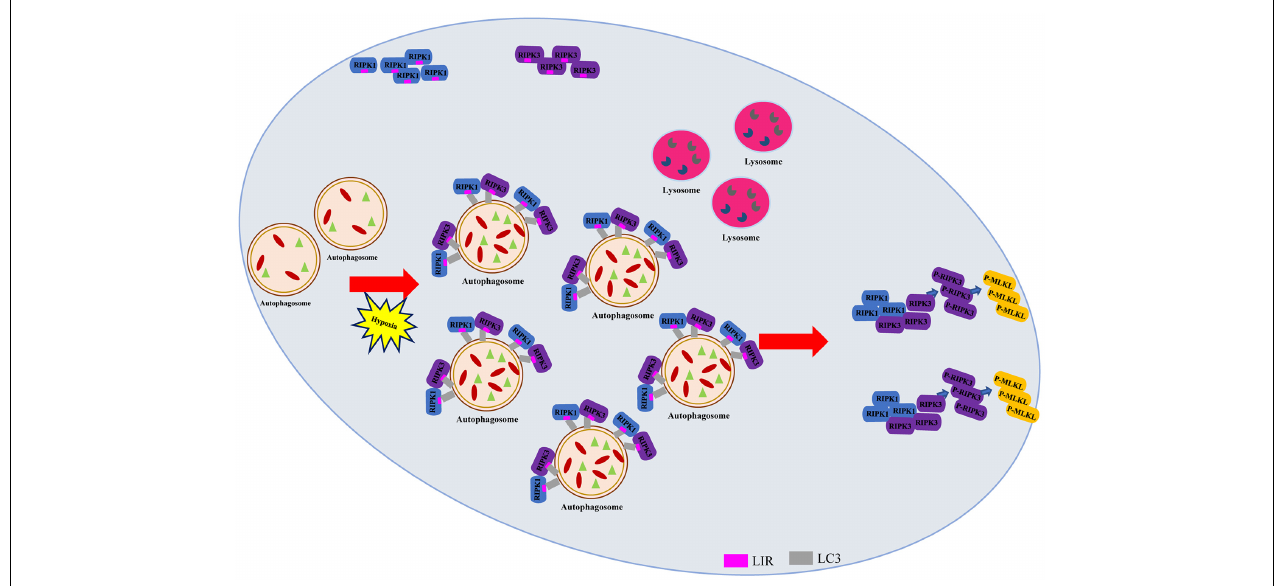
FIGURE 7 | Autophagy-related LC3 accumulation stimulates necroptosis through direct interaction of LC3 with RIPK1 and RIPK3 in hypoxic cardiomyocytes. Schematic diagram on the proposed process where impaired autophagic flux contributes to necroptosis through interaction between LC3, RIPK1, and RIPK3 in hypoxic